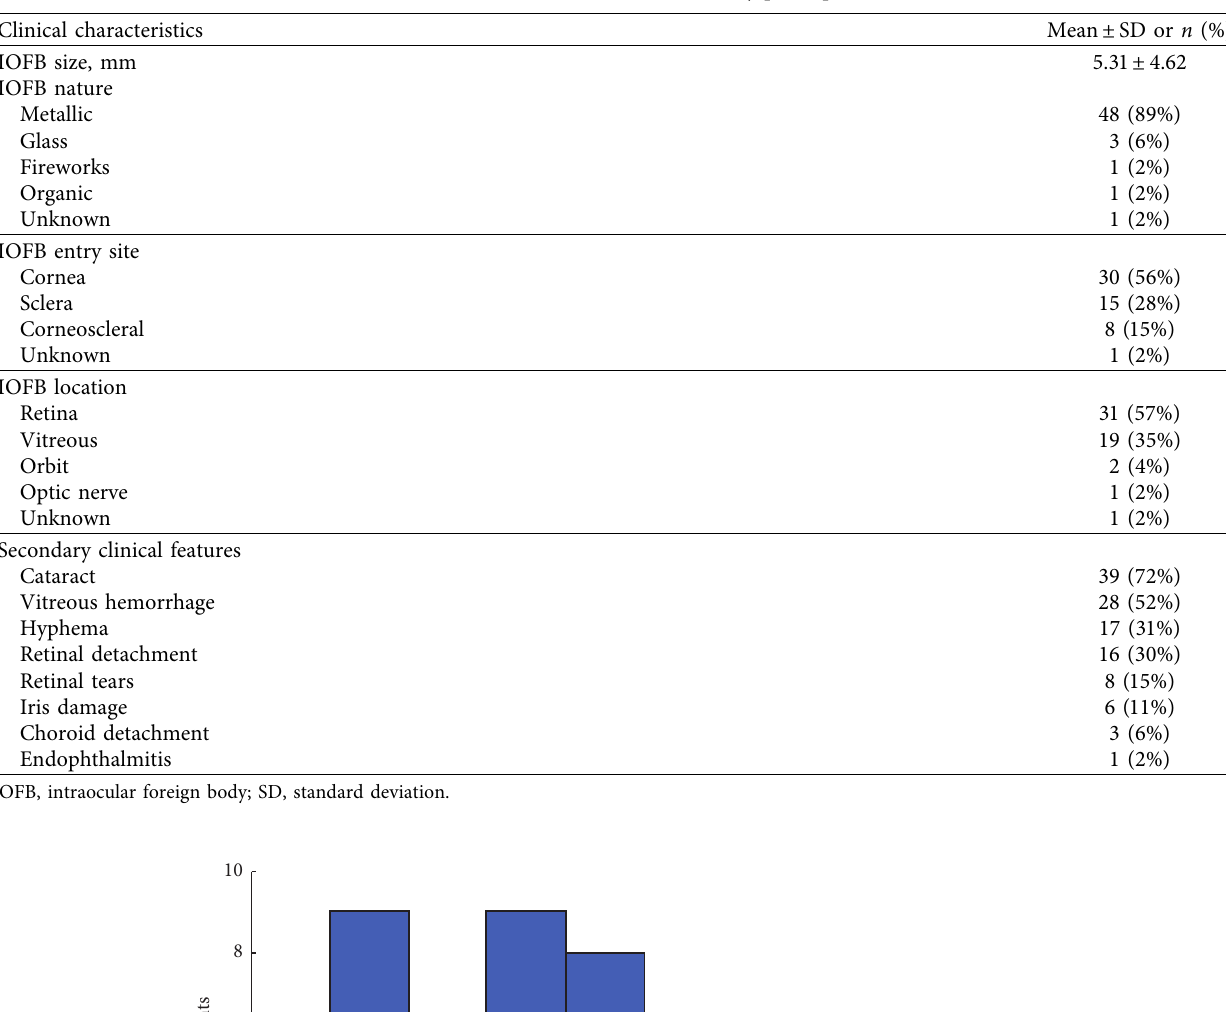
Table 1: Clinical characteristics of 54 study